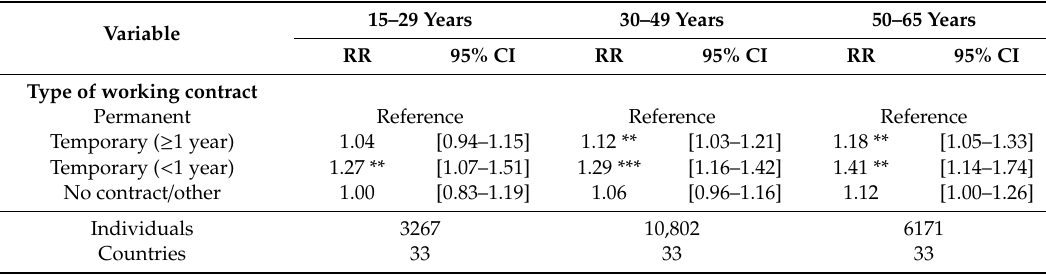
Table 3. Rate ratios (RR) of presenteeism propensity by employment contract and age.